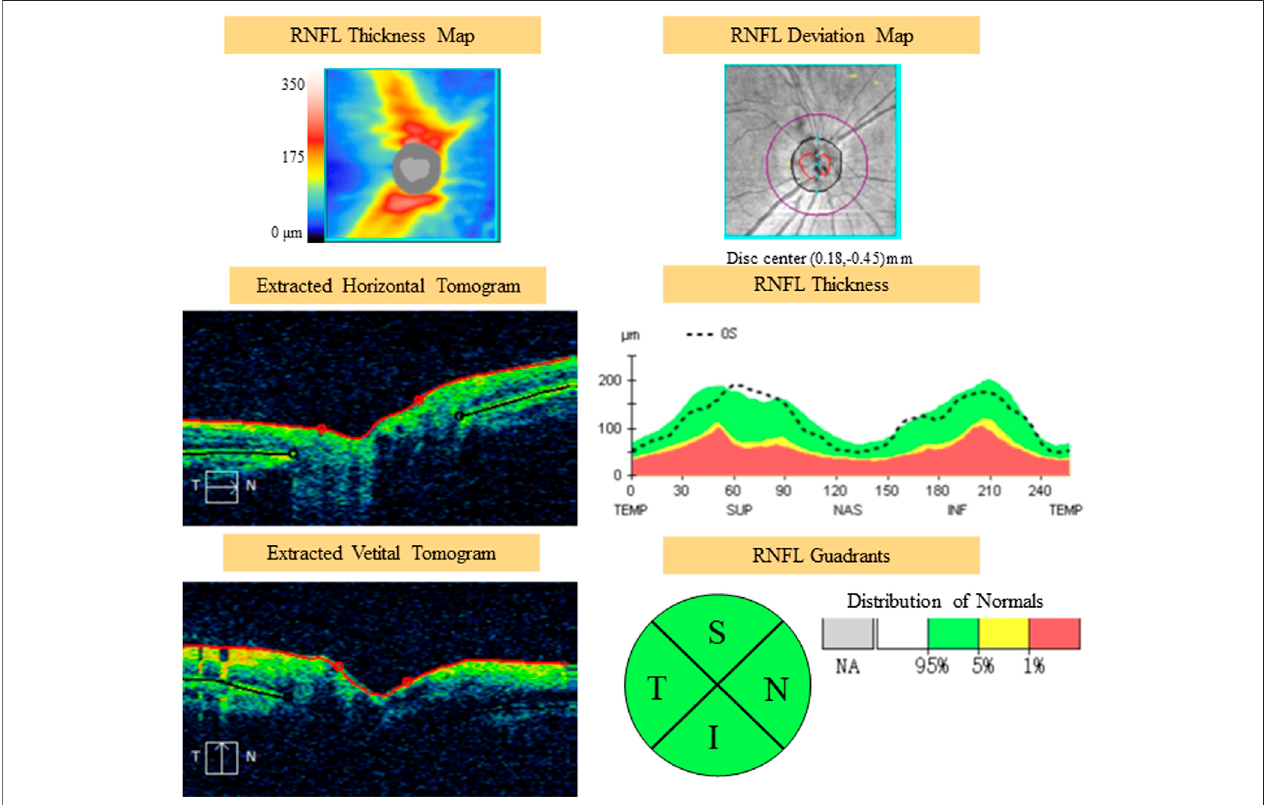
FIGURE 1 | Example of scanning and measurements of RNFL with OCT. RNFL, retinal nerve fi ber layer; OCT, optical coherence tomography; S, superior area; I, inferior area; N, nasal area.